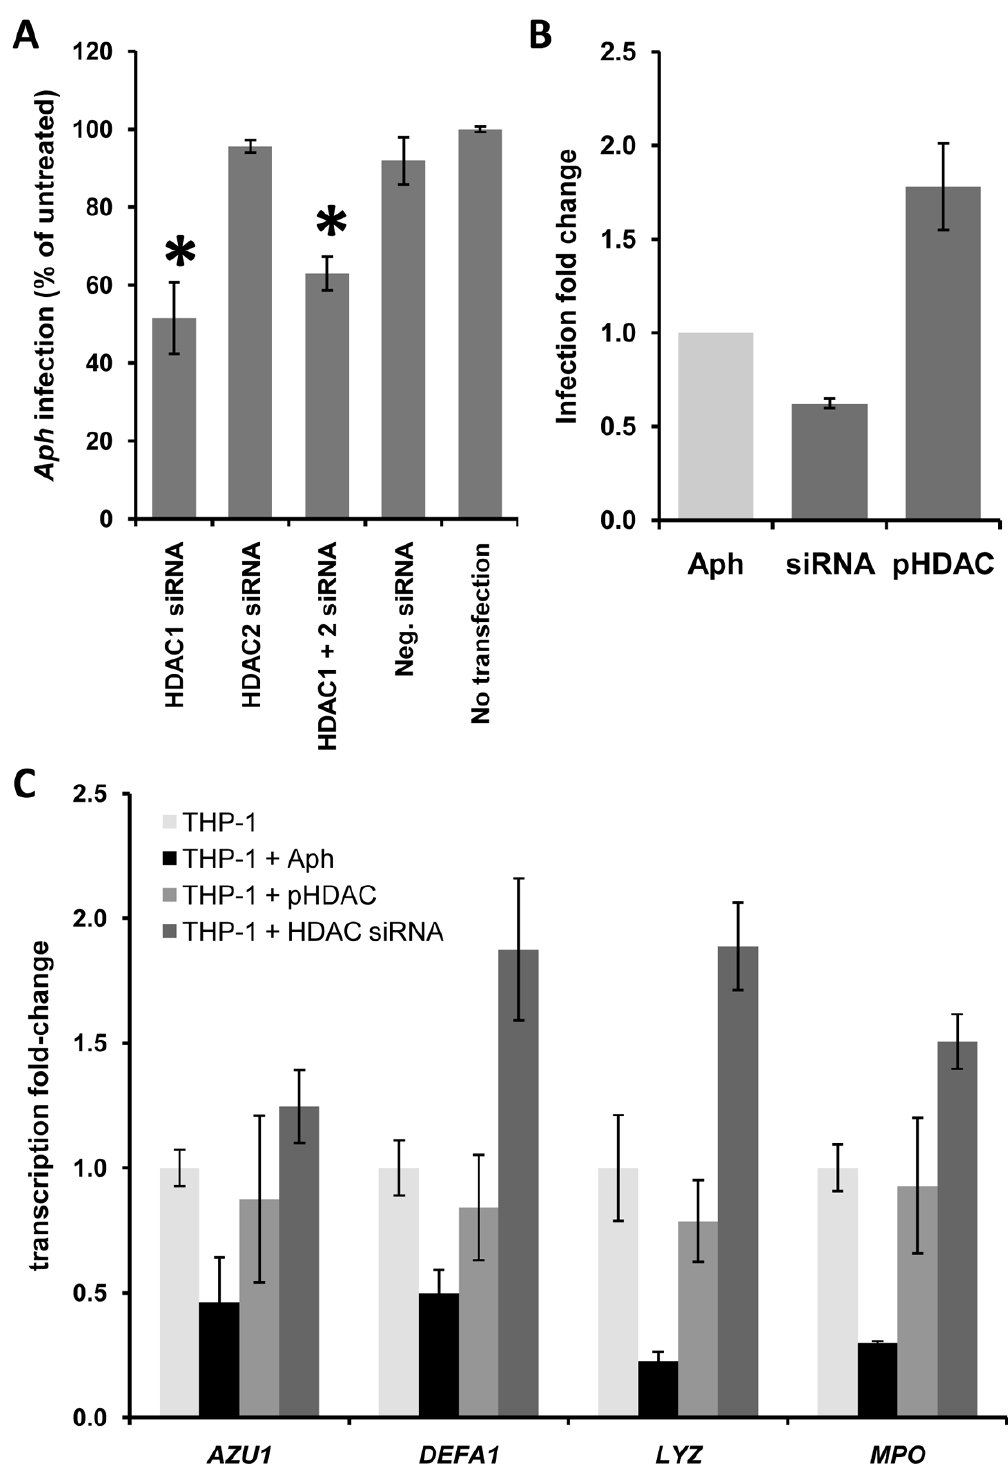
Figure 5. HDAC1 silences defense gene expression and facilitates A.phagocytophilum infection of THP-1 cells. (A) THP-1 cells were transfected with HDAC1 or HDAC2 siRNA and were infected 24 hours after transfection with cell-free A. phagocytophilum . The A. phagocytophilum load was determined 24 h after infection by qPCR and normalized to infection levels in non-transfected cells. (B) THP-1 cells were transfected with HDAC1 siRNA for silencing or with pHDAC1-FLAG plasmid to overexpress HDAC1 and were infected 24 hours after transfection with cell-free GFP- expressing HGE-1 strain of A. phagocytophilum . The percent of infected cells was determined 24 h after infection by flow cytometry and normalized to infection levels in untreated cells. (C) Expression of defense genes by THP-1 cells infected with A. phagocytophilum –infected or transfected with pHDAC1-FLAG plasmid or HDAC1 siRNA was determined by qRT-PCR. Gene expression was normalized to housekeeping genes and to the level of expression of untreated, uninfected THP-1 cells.